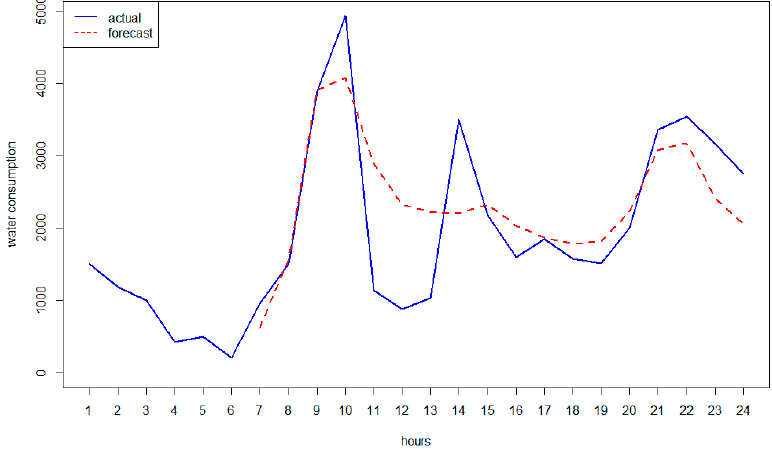
Figure 12. Case 1—actual consumption versus forecast for the day with the highest MAPE.